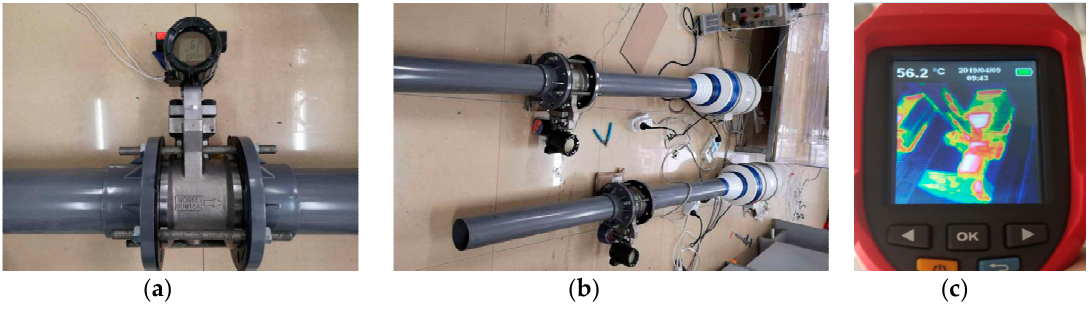
Figure 13. Images of ( a ) digital vortex flowmeter, ( b ) connection of vortex flowmeter and ventilator, and ( c ) thermal Infrared Imager.